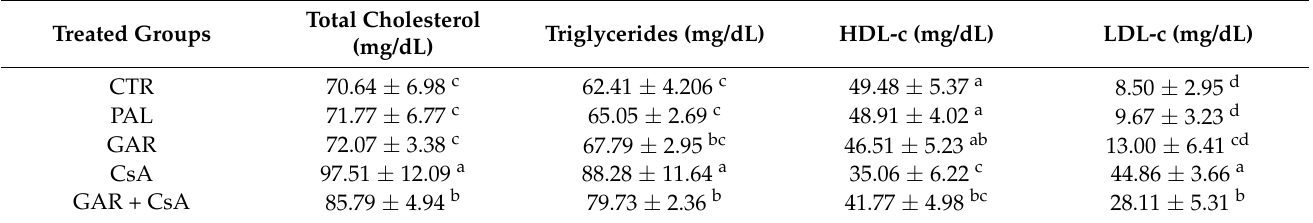
Table 3. Effect of treatment with Cyclosporine (CsA) and/or Garlic on serum levels of total cholesterol, triglycerides, HDL-c, and LDL-c in male Westar albino